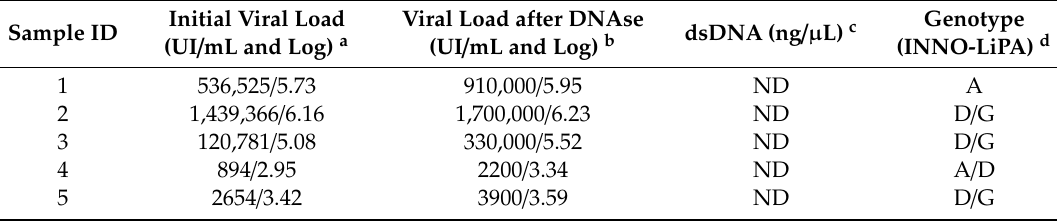
Table 1. Sample information of hepatitis B (HBV) mono-infected